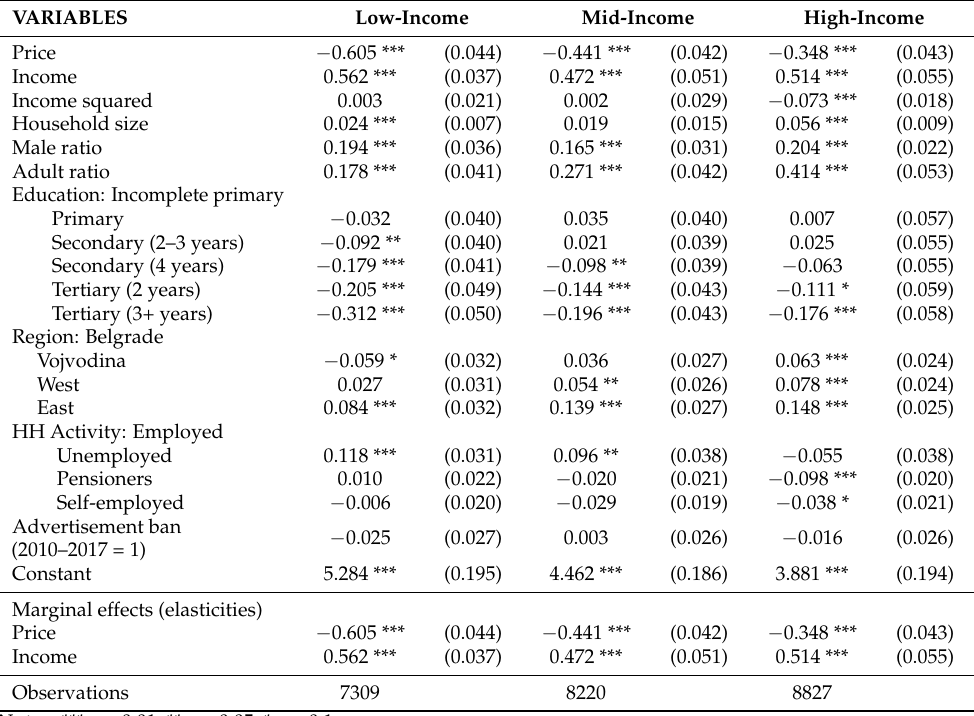
Table A6. GLM estimation of the intensity elasticity by income groups.